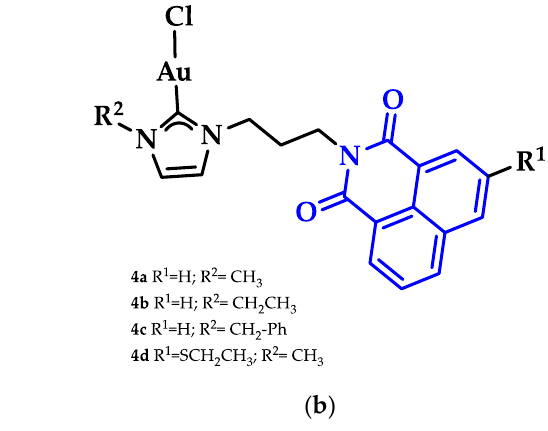
Figure 13. ( a ) Chemical structure of naphthalimide moiety and 1-( 3′ -aminopropyl)-imidazole ligands; ( b ) Chemical structures of series of Au(I)-NHC complexes with naphthimide moieties.